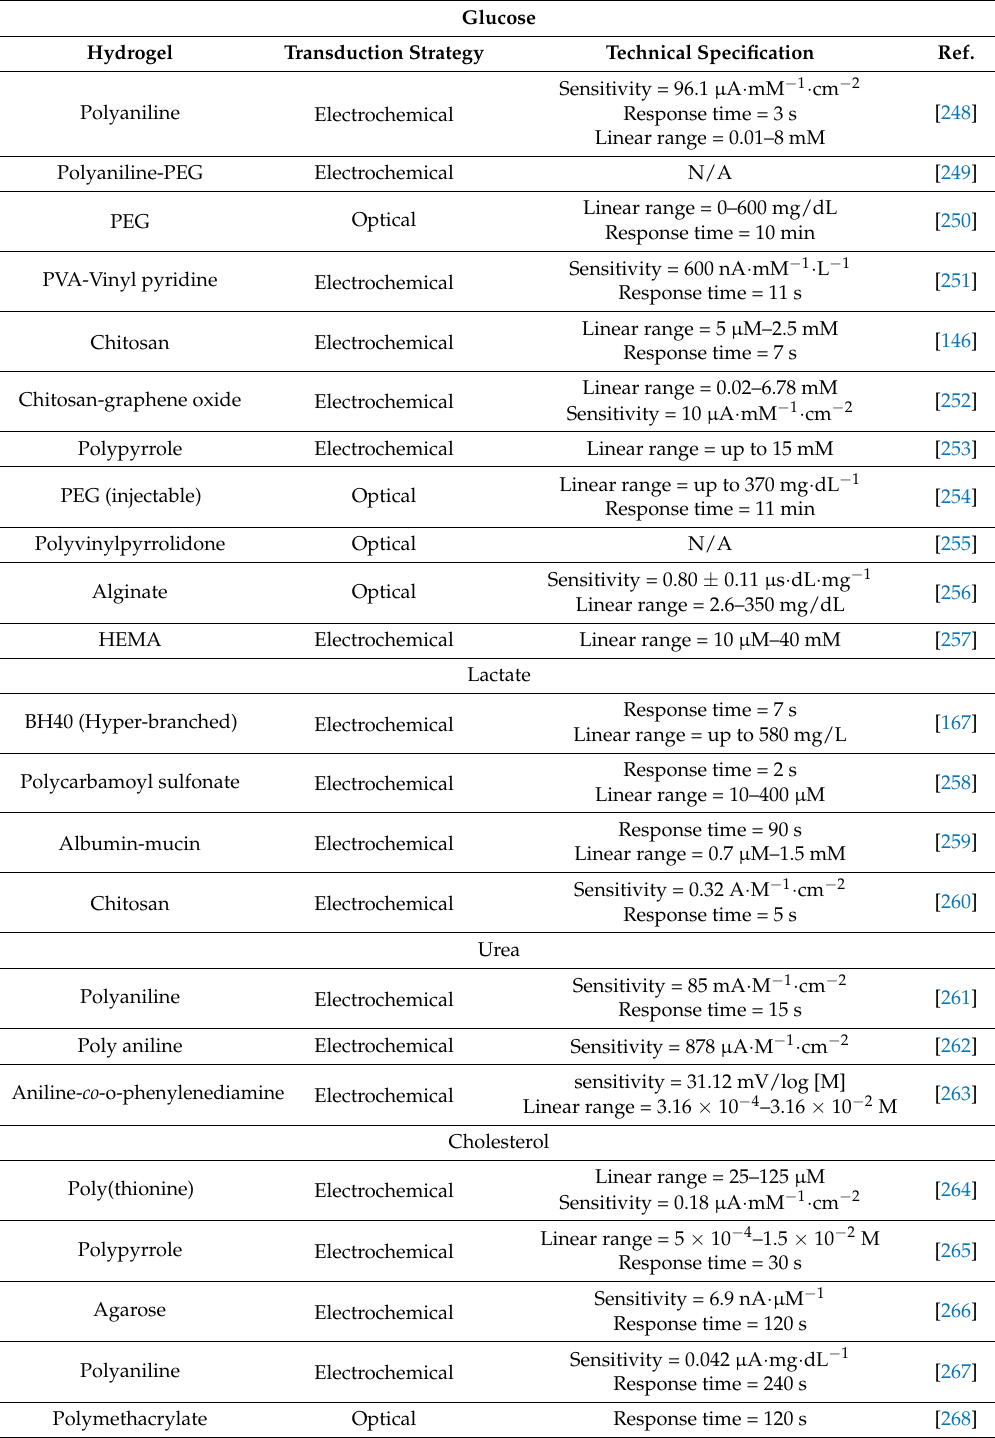
Table 2. Strategies for small biomolecule detection using hydrogel based biosensors